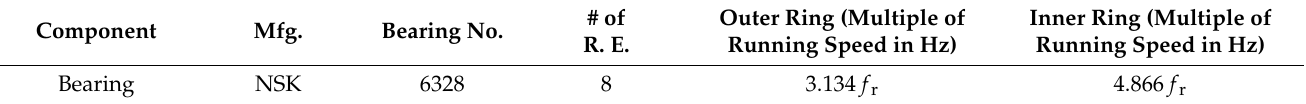
Figure 6. Outer ring fault of rolling bearing at driving end of wind power generator.